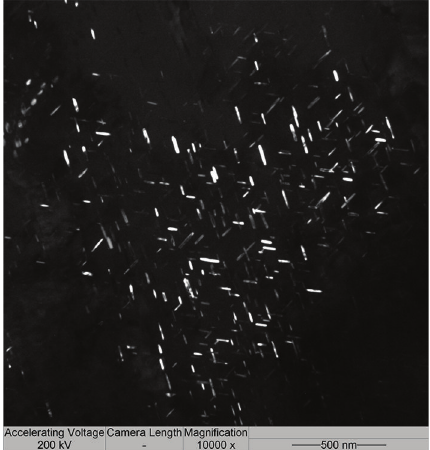
Figure 2: Dark field TEM image of precipitates aged at 200 ∘ C for 8h.